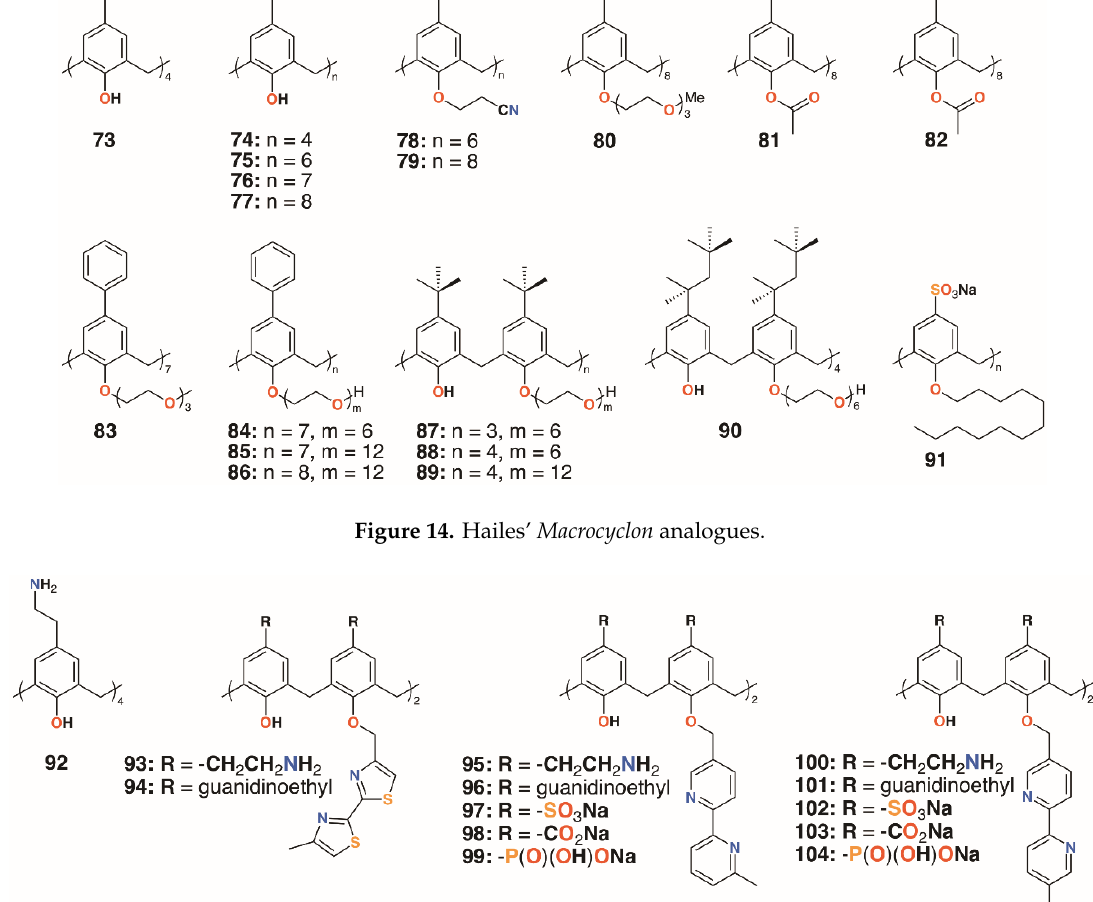
Figure 15. Regnouf-de-Vains’ charged calixarenes.